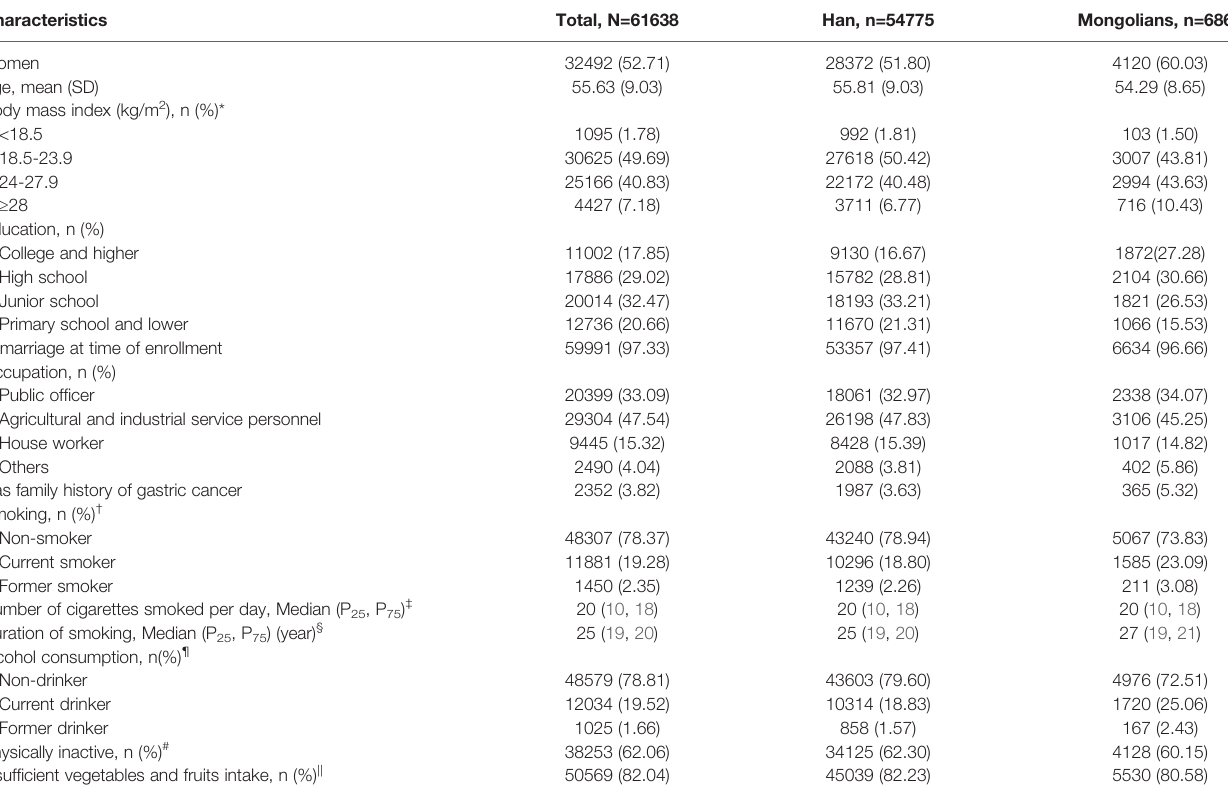
TABLE 1 | Basic characteristics of participants grouped by